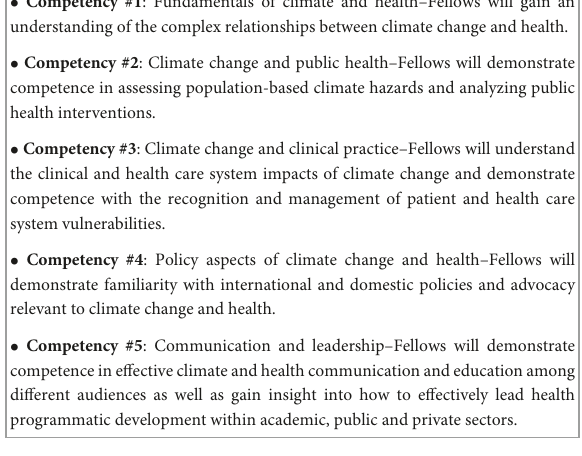
TABLE 1 Set of competencies for the climate change and human health physician